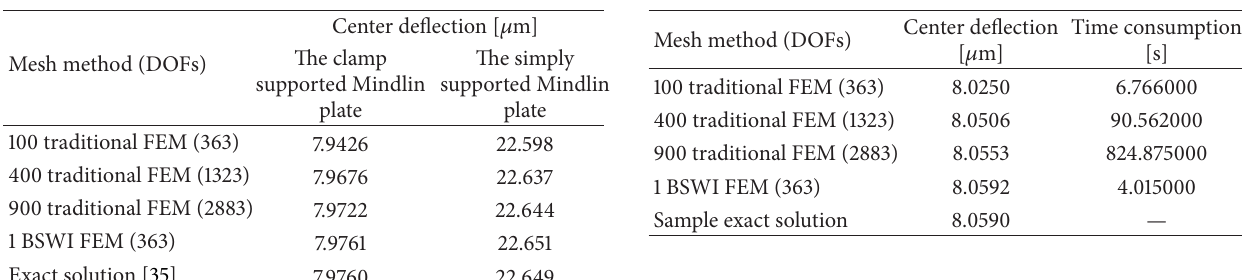
Table 3: Comparison of center deflection of the clamp and simply supported Mindlin plate under uniform load.